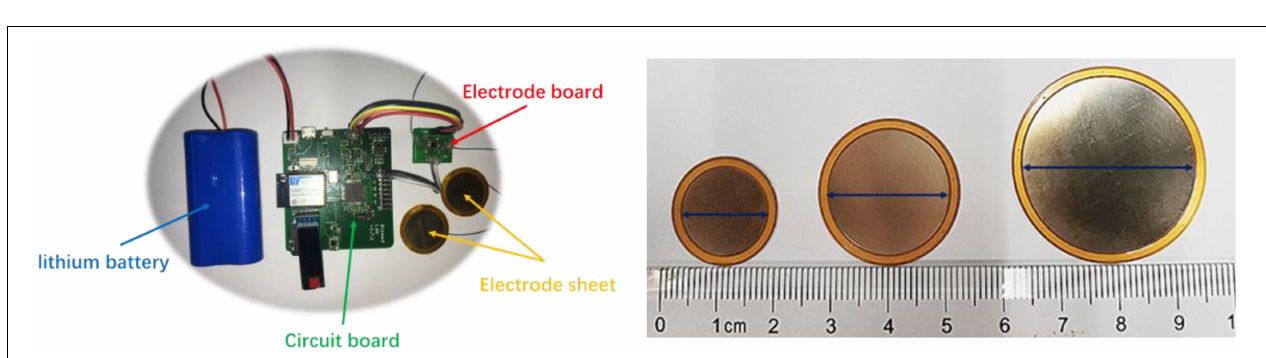
FIGURE 1 | The overall design block diagram of the non-contact ECG signal acquisition system.